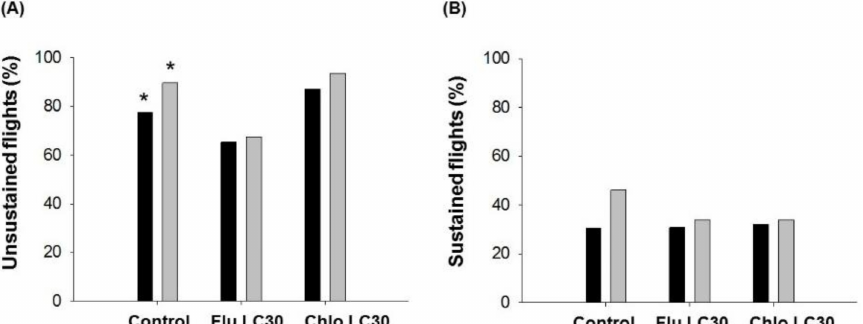
Figure 8. Proportion of Chloridea virescens that (A) engaged in unsustained (<30 min) or (B) sustained flights (>30 min). Black bars represent female and grey bars represent male moths. The asterisks indicate significant differences among treatments for a given comparison ( χ 2 , α = 0.05).